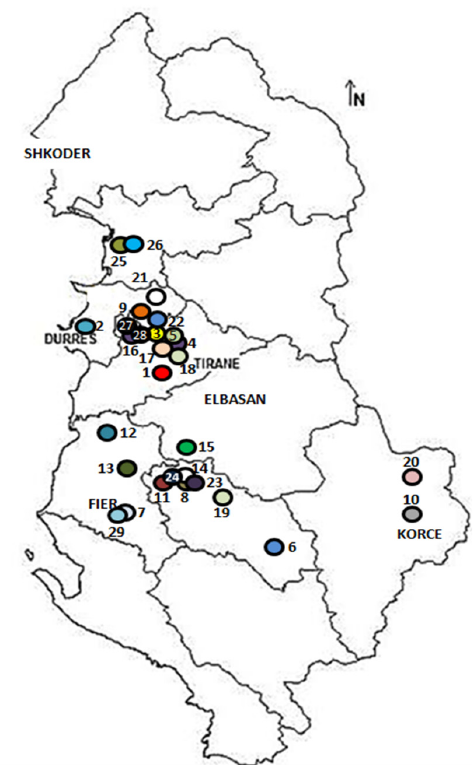
Figure 1. Albania (www.d-maps.com) with its prefectures and the localities, where chamomile flower samples were collected: 1. Baldushk, 2. Rruga Gjiri i Lazit, 3. Zall Her, 4. Dajti, 5. Linz ȅ , 6. Skrapar: Melove, 7. Verbas, 8. Kuçovë, 9. Krujë: Larushk, 10. Korçë, 11. Poshnje: Berat, 12. Karbunarë Lushnjë,